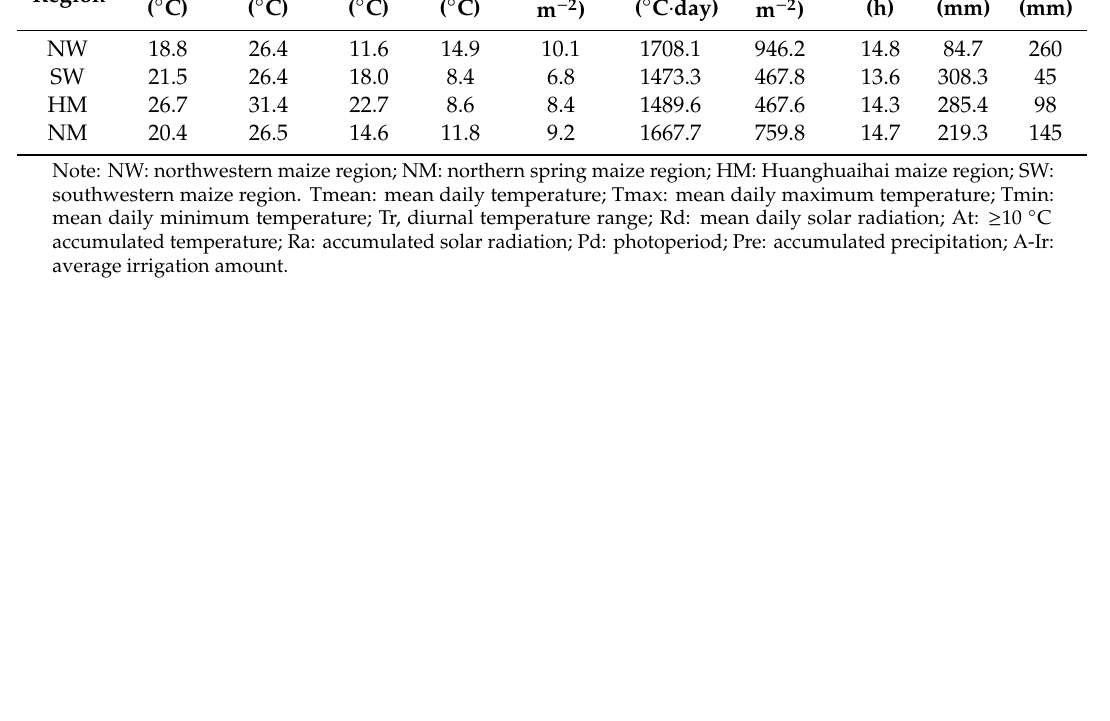
Table 1. Climatic conditions and irrigation amount during the vegetative growth stage in the four studied maize-growing regions in 2013–2016.